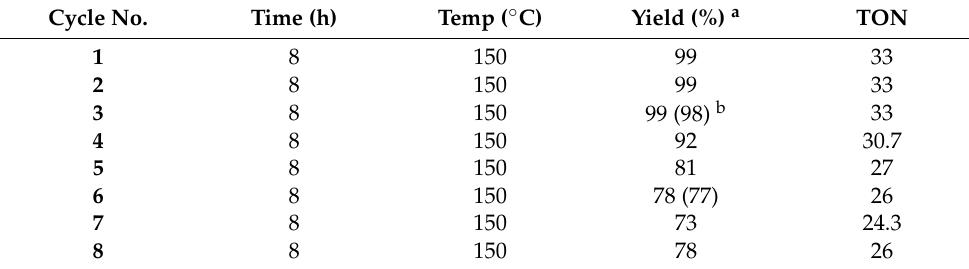
Table 9. Recycling results of 2a -catalyzed Suzuki-Miyaura reaction of aryl boronic acid ( 11 ) with 4-cyanobromobenzene ( 16 ) under the thermomorphic mode. Cycle No.